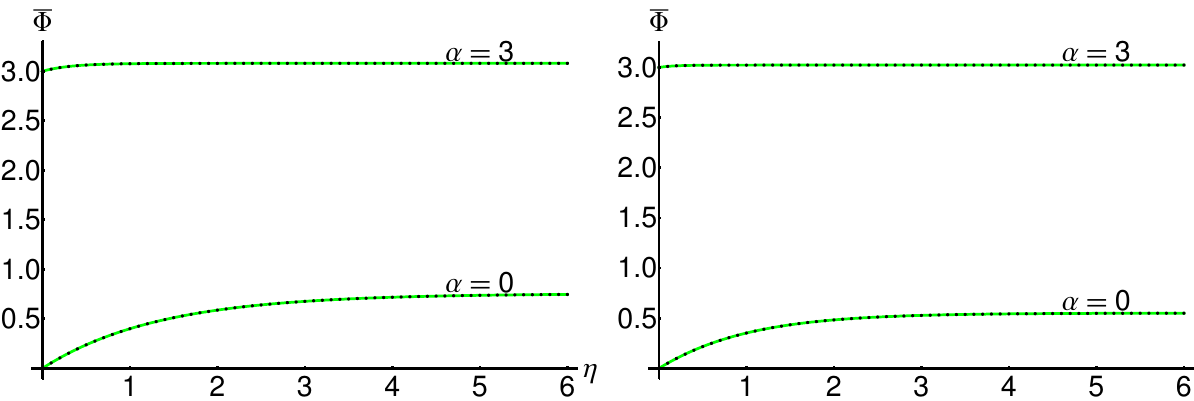
Figure 5: Variation of Φ by increasing the coeflcient α for planar flow ( m = 1, λ = 1) :